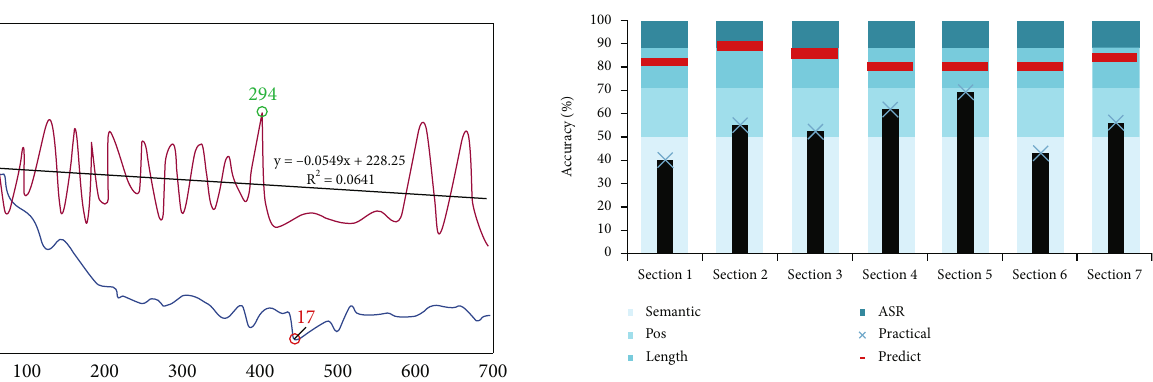
Figure 2: Comparison of stability between traditional and intelligent question answering systems under di ff erent test conditions.